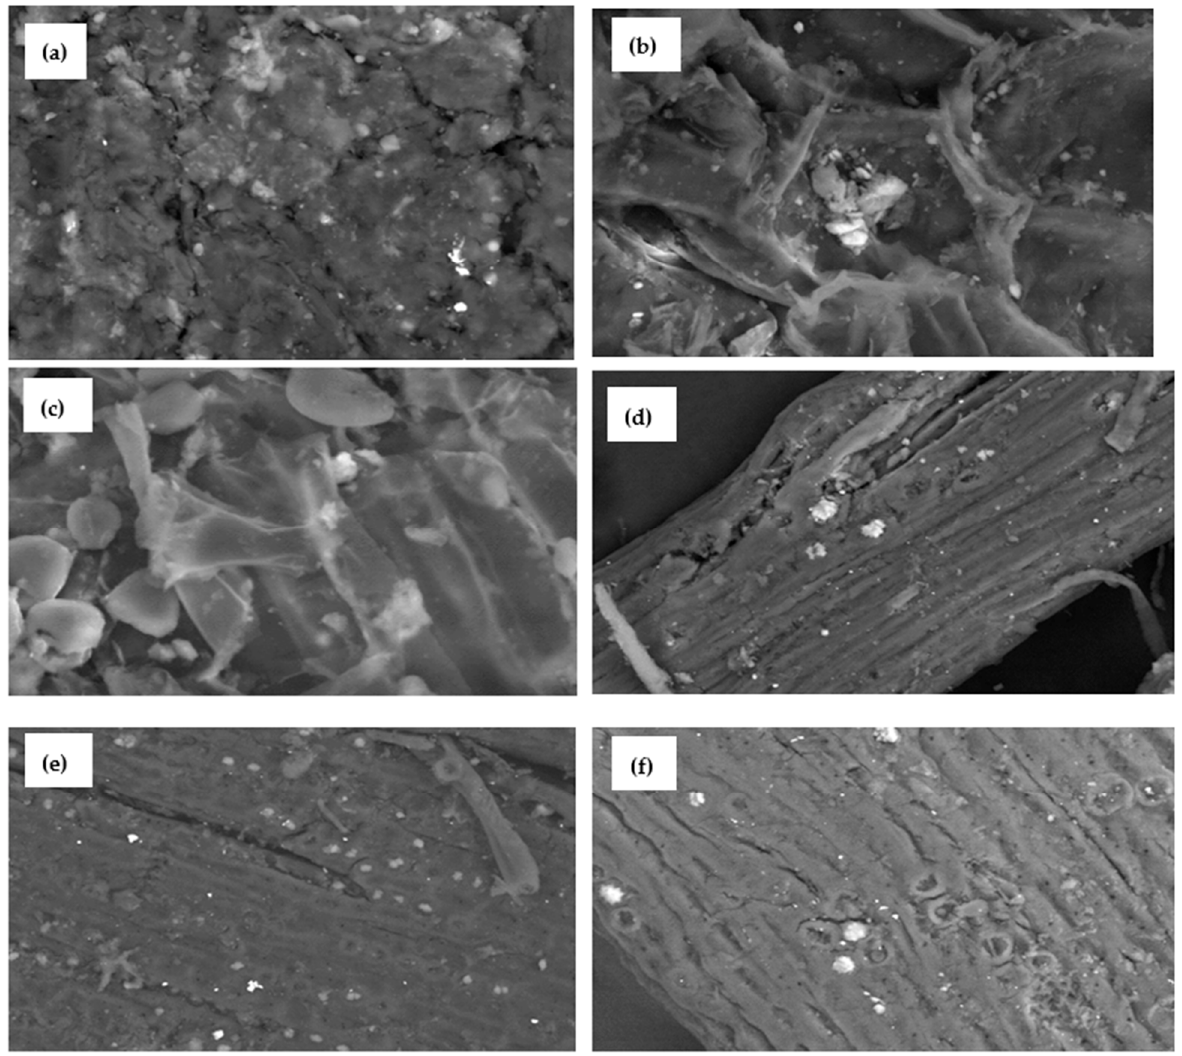
Figure 4. SEM micrograph of OPB ( a ) before the adsorption process, and ( b ) yam after the Cr(VI) adsorption process and ( c ) after the Ni(II) adsorption process; and YP ( d ) before the adsorption process, and ( e ) yam after the Cr(VI) adsorption process and ( f ) after the Ni(II) adsorption process; SEM micrographs have magnification ×500.